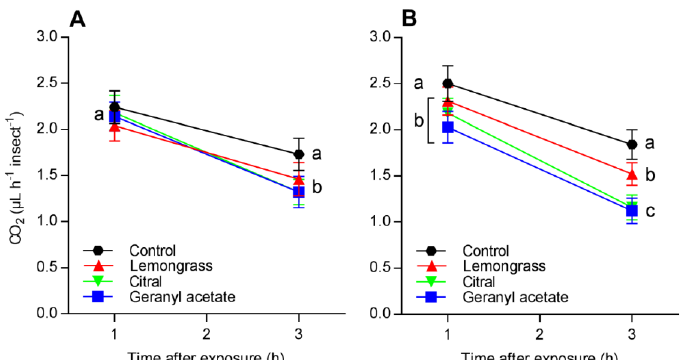
Figure 4. Respiration rate (mean ± SEM) of Sitophilus granarius adults after exposure to lemongrass essential oil, citral, and geranyl acetate, for levels ( A ) LD 50 and ( B ) LD 90 . Treatments (mean ± SEM) differ at p < 0.05 (Tukey’s mean separation test).